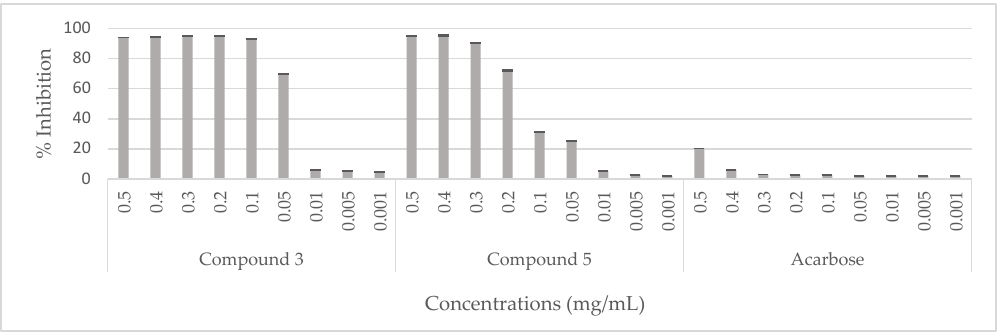
Figure 6. Hypoglycemic effect of compounds ( 3 and 5 ) isolated from C. villosa stems extracts. All values are expressed as mean of triplicate ± SD.